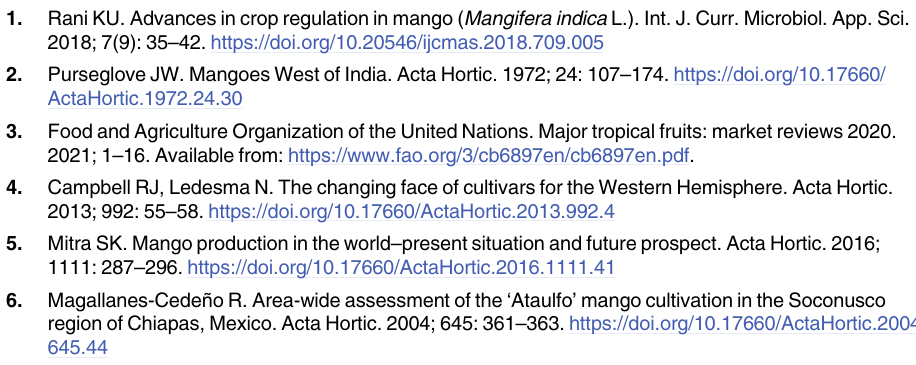
S5 Table. Thrips catches. Means of Frankliniella thrips in seven samplings throughout the flowering period of Ataulfo mango in Chiapas, Mexico. Figures of each sampling represent the average specimens collected in 20 mango